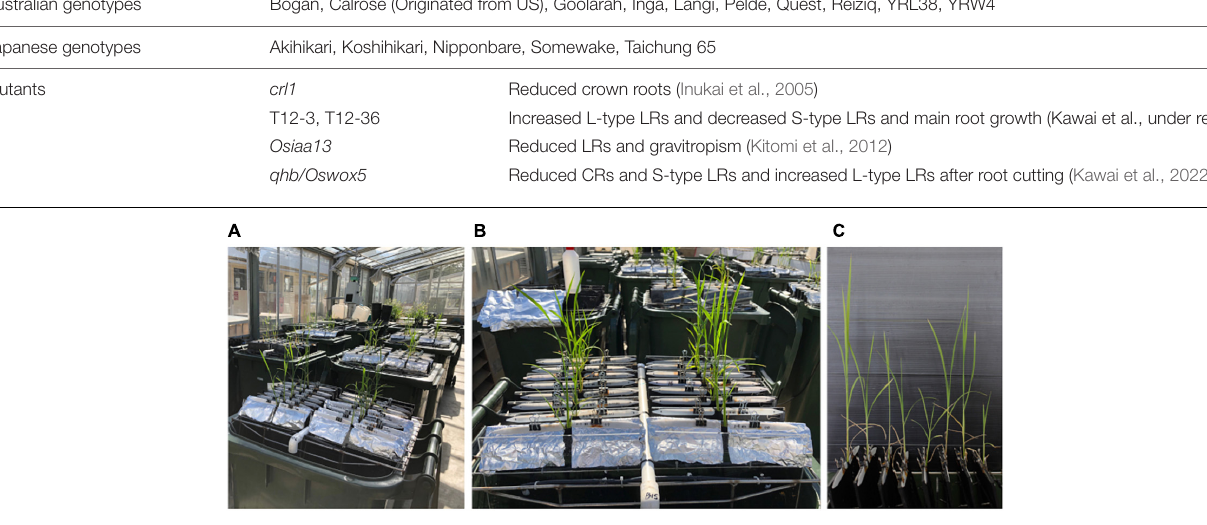
three to six replications per genotype were analyzed their shoot and root